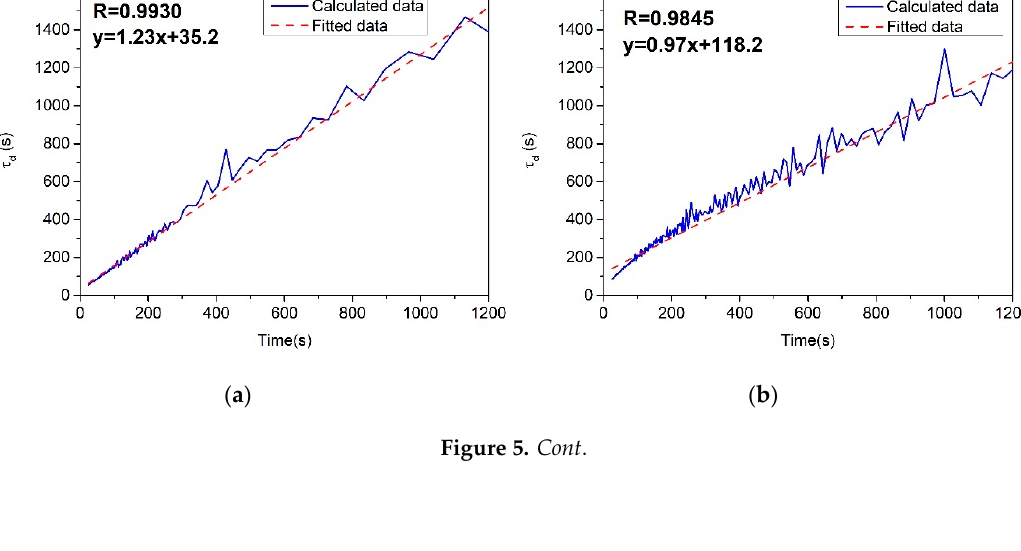
Figure 4. Comparison between equal time interval and equal voltage interval method.